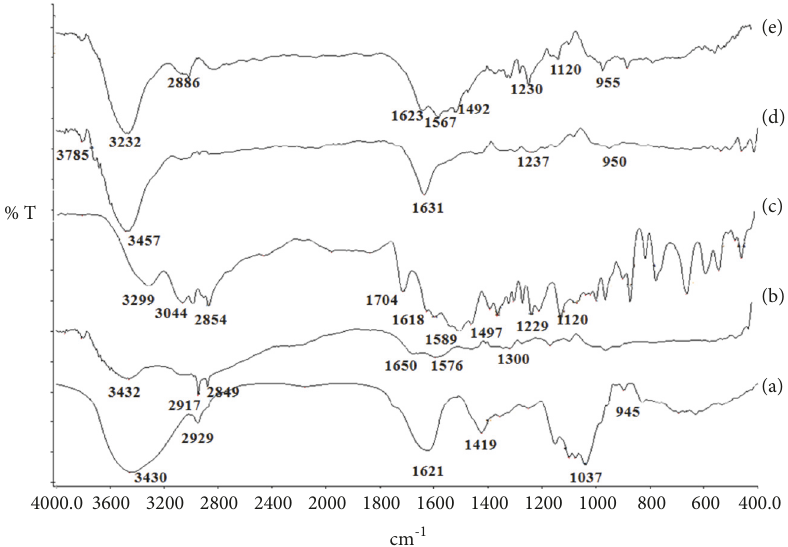
Figure 1: FTIR spectra of (a) FX, (b) CH, (c) TML, (d) blank nanoparticles, and (e) drug loaded optimized nanoparticles.